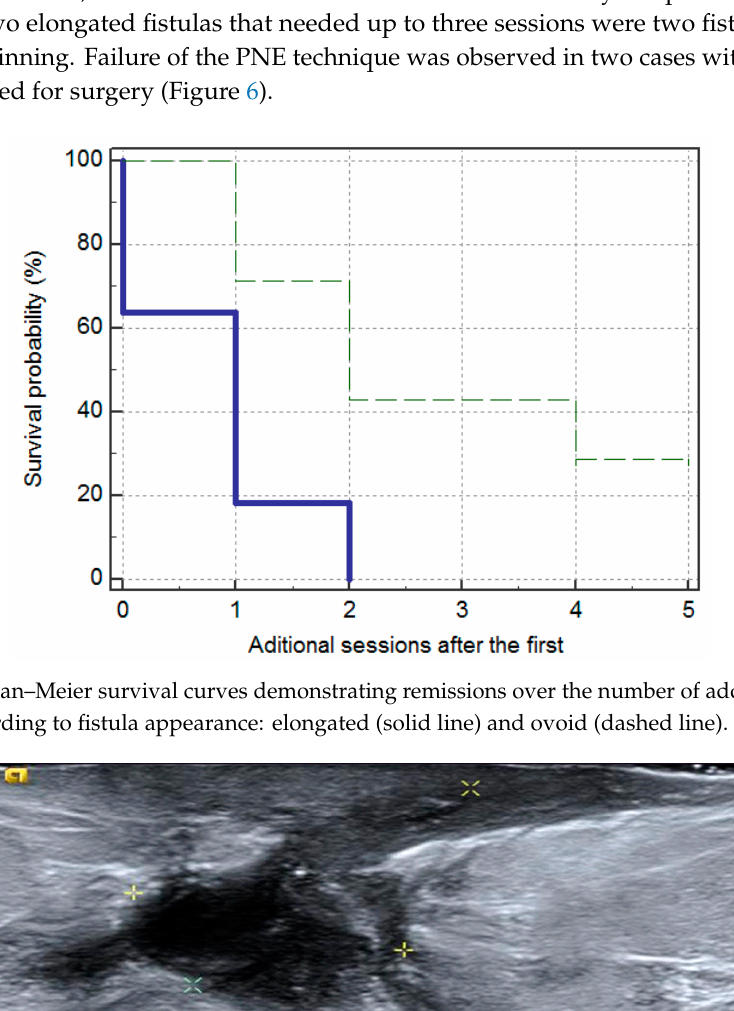
Figure 4. Kaplan–Meier survival curves demonstrating remissions over a period of 26 weeks, according to fistula appearance: elongated (solid line) and ovoid (dashed line).